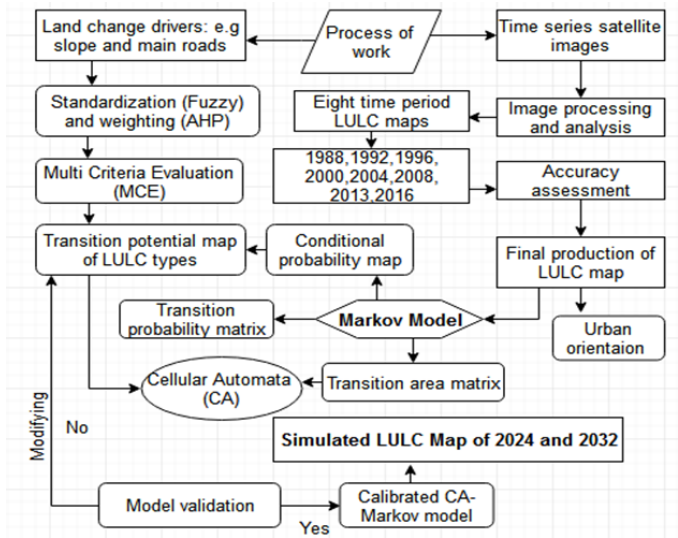
Figure 2. Framework of the study.